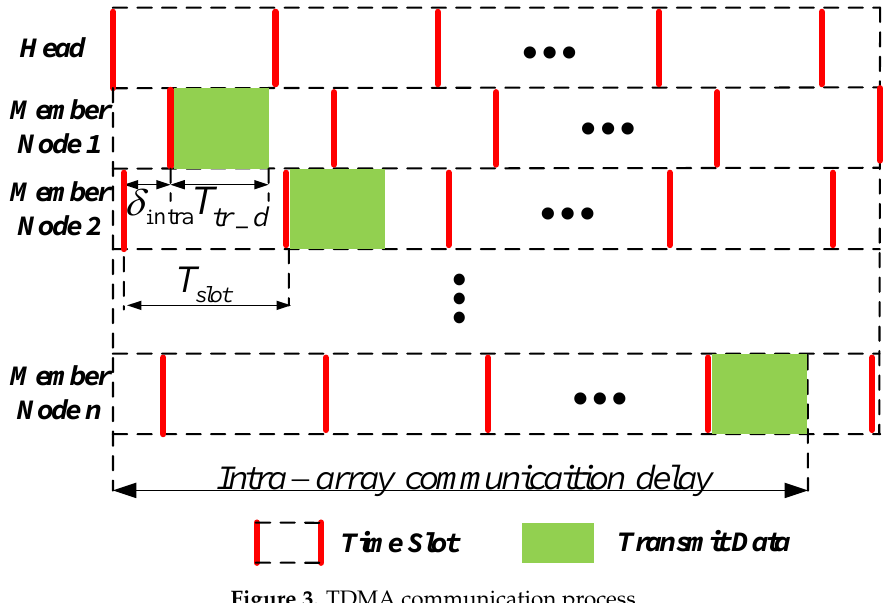
Figure 3. TDMA communication